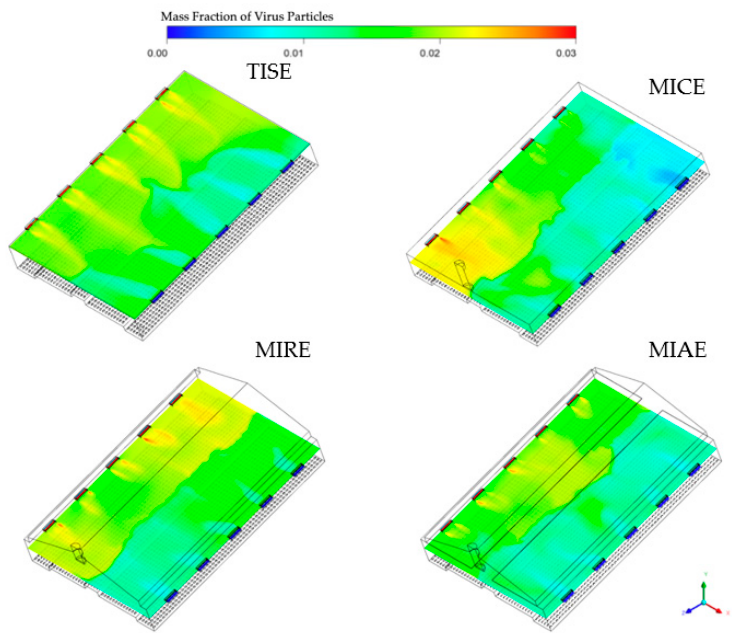
Figure 4. Contours of virus mass fractions at TP-I in the four models. Simulated virus particles were introduced from upwind side inlets (left).